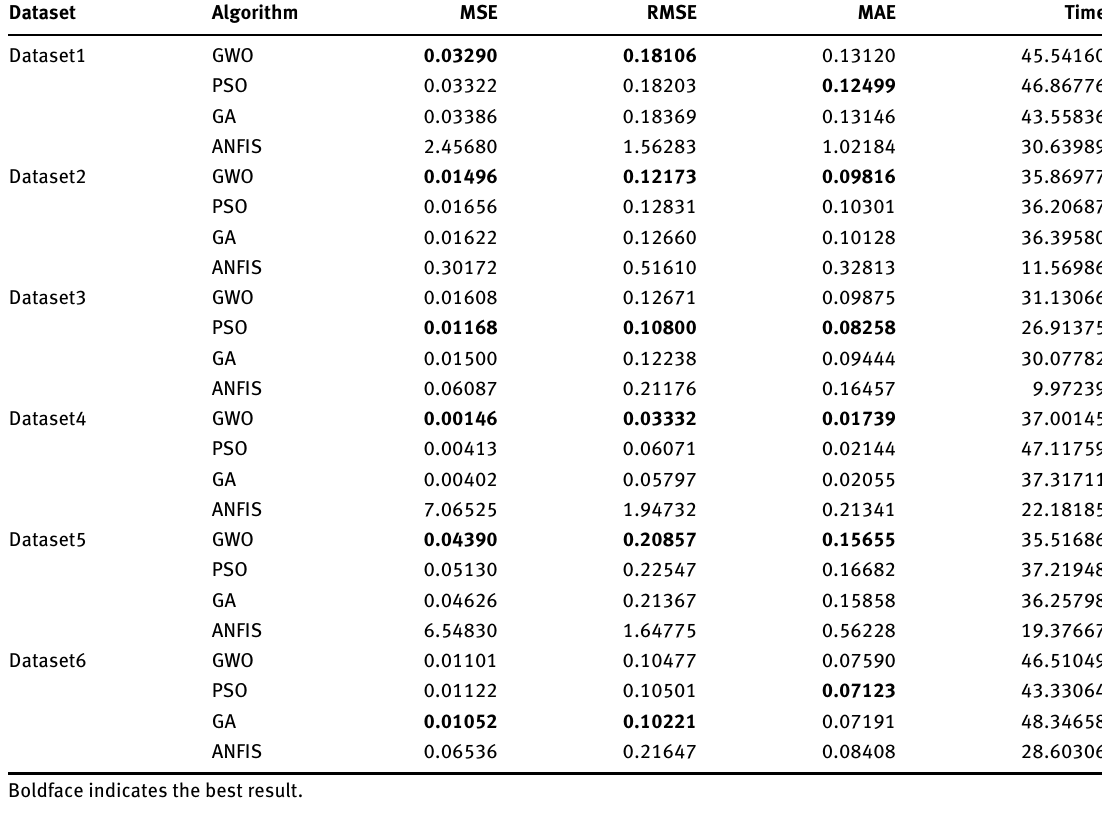
Table 2: Results of ANFIS-GWO Over Six Datasets against Three Algorithms. Dataset